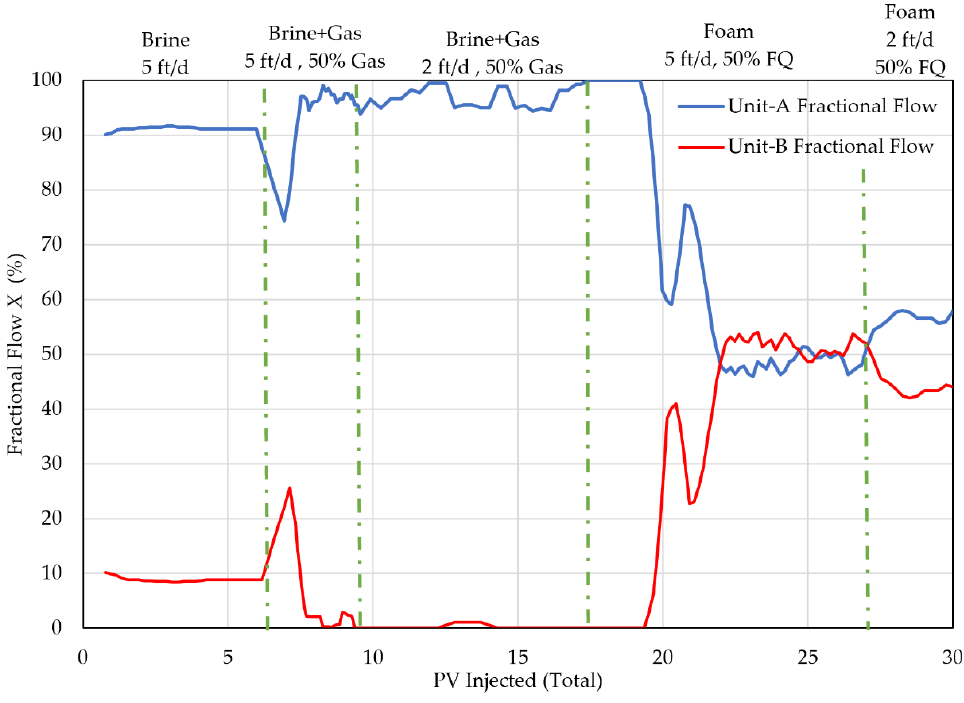
Figure 9. Fractional flow through Unit-A and Unit-B cores for DI-Exp 1.